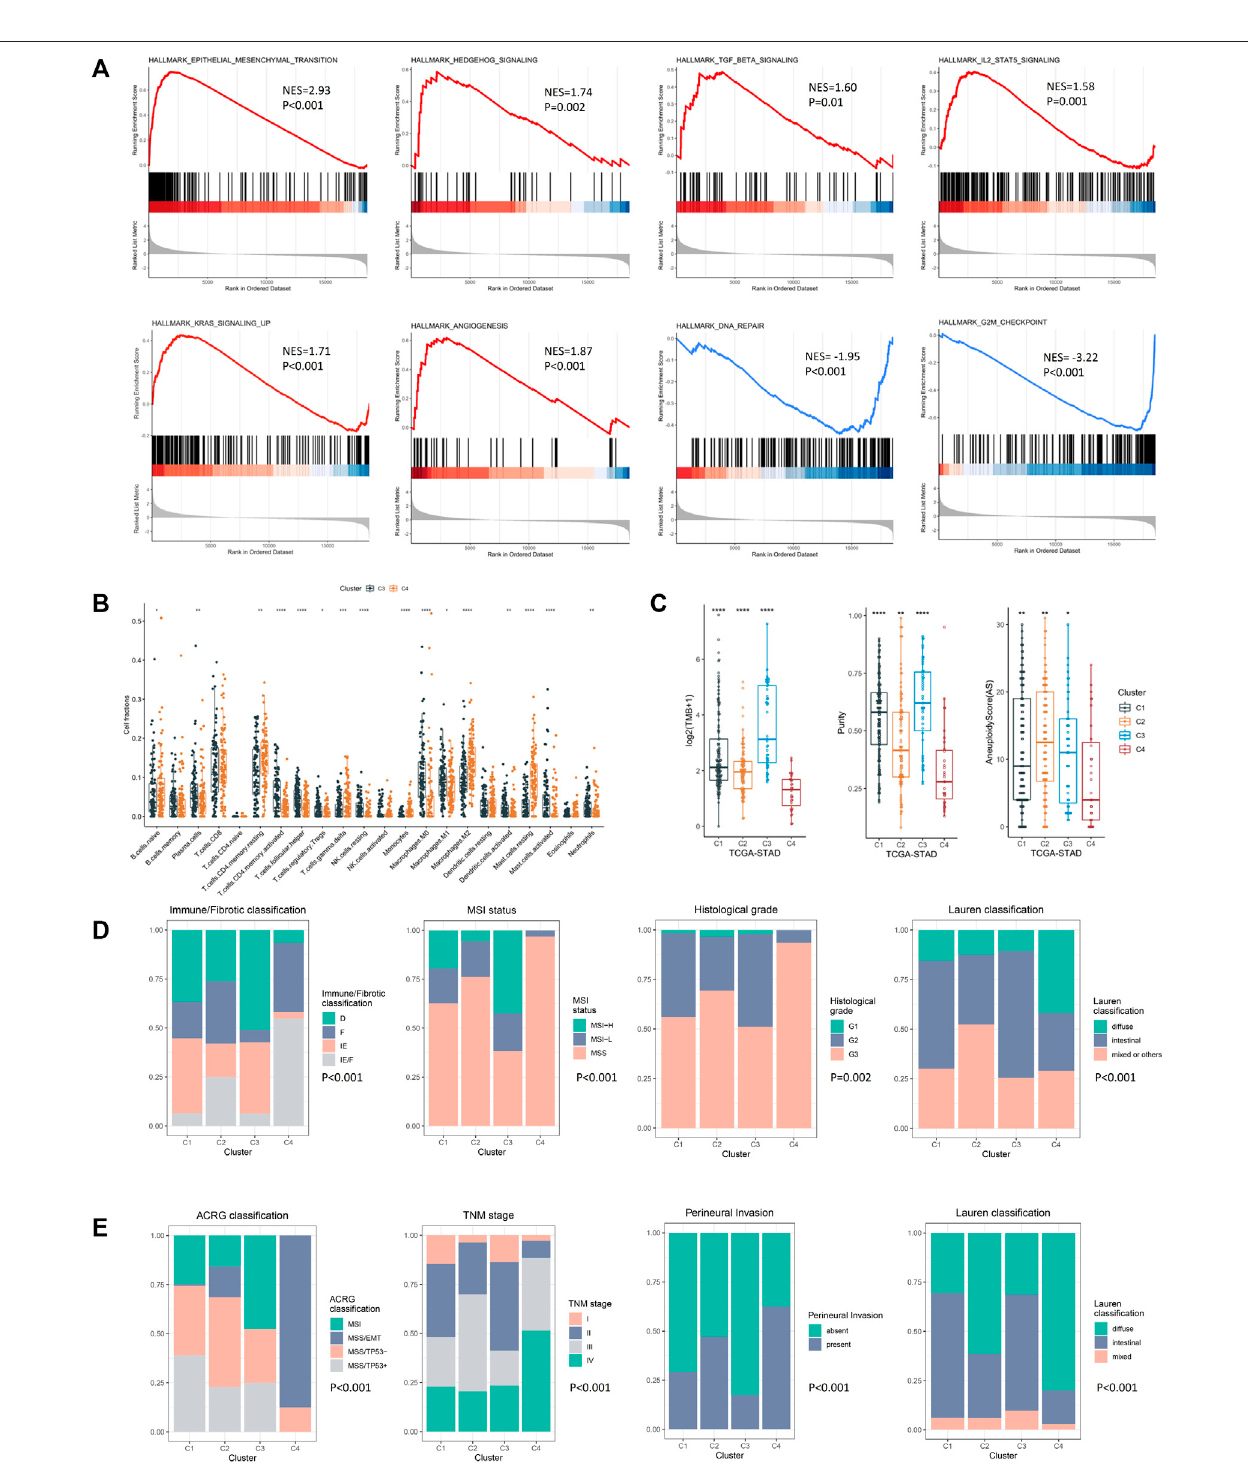
FIGURE5| Molecularandclinicalcharacteristicsoffourepigeneticmodi fi cationpatterns. (A) GSEAanalysisidenti fi edthedifferentiallyactivatedpathwaysofcluster C4comparedwithclusterC3. (B) CIBERSORT analysisestimated therelativeratiooftumor-in fi ltrating cellsinclustersC3and C4.Eachvaluewasde fi ned astherelative ratio compared to the 22 human hematopoietic cell types contained in CIBERSORT. (C) Different TMB, tumor purity, and aneuploidy score among four clusters in the TCGA-STADcohort. (D) Clinical relevance ofthe EMD subtype in theTCGA-STAD cohort. (E) Clinicalrelevanceof theEMD subtype in the GSE62254 cohort(* p < 0.05, ** p < 0.01, *** p < 0.001, and **** p < 0.0001).